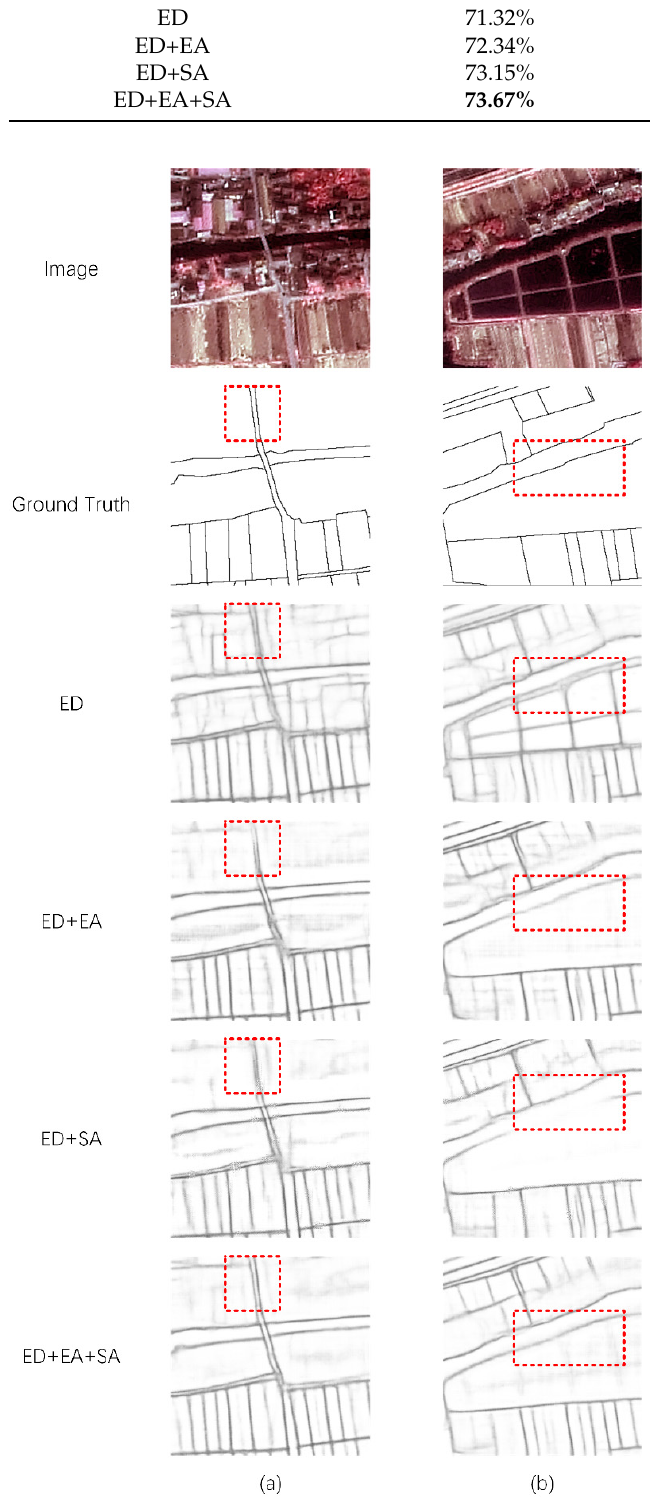
Figure 3. Comparison of the results of the ablation study. ( a , b ) are the results of different images. For each image, we show the results of the ED module, ED module with EA module, ED module with SA module, and our full method.